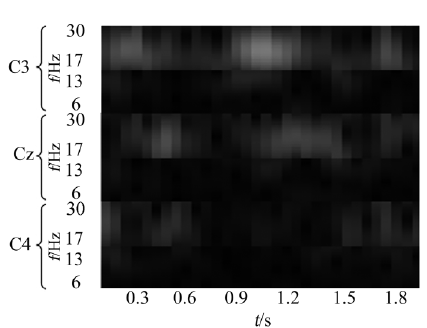
Figure 6. Sample input image of left hand MI